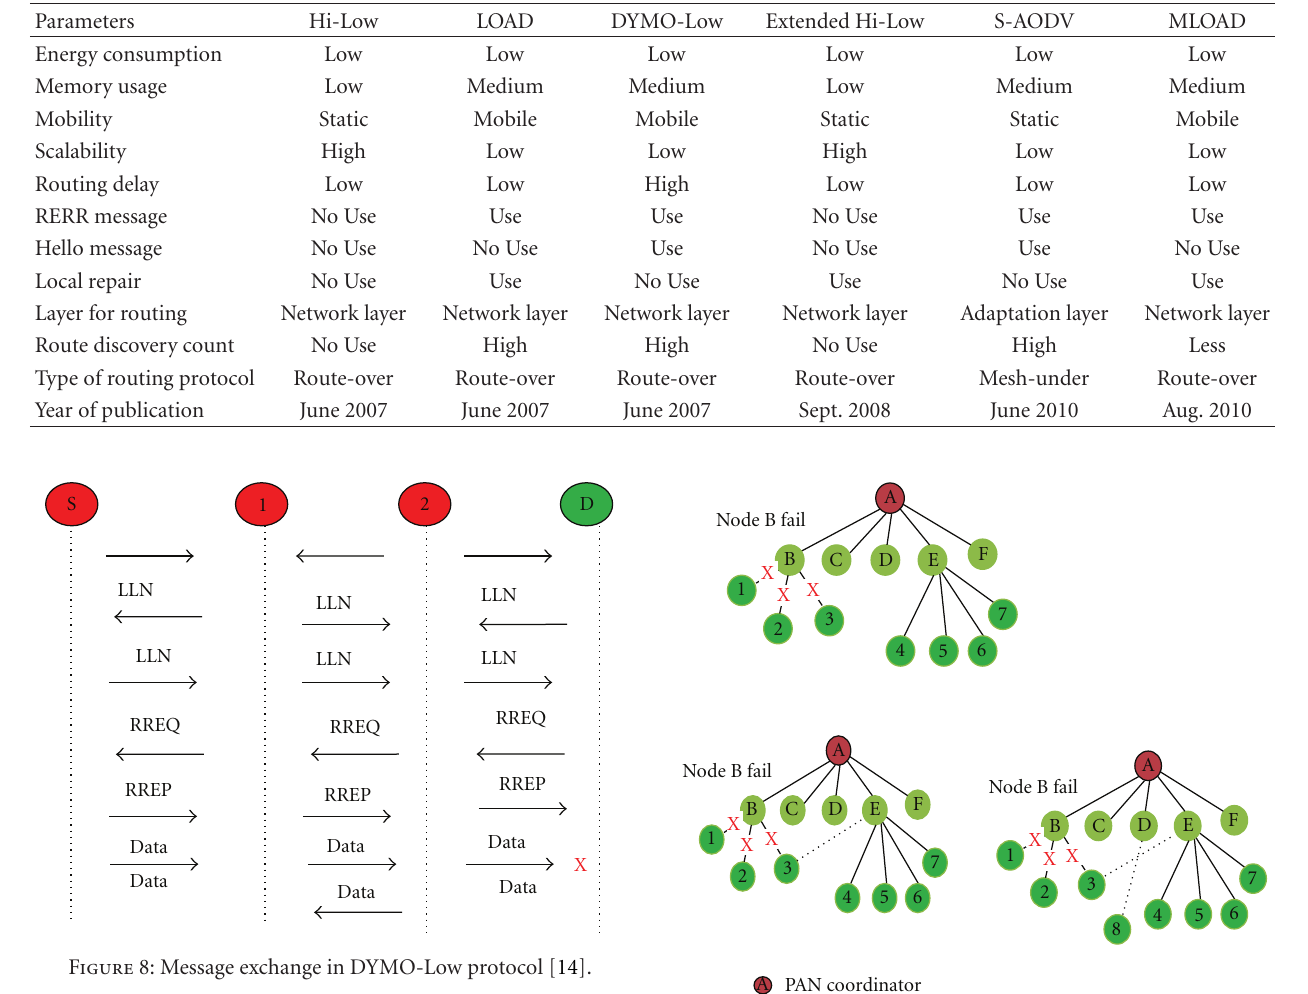
Table 1: Comparisons of di ff erent routing protocols in 6LoWPAN.